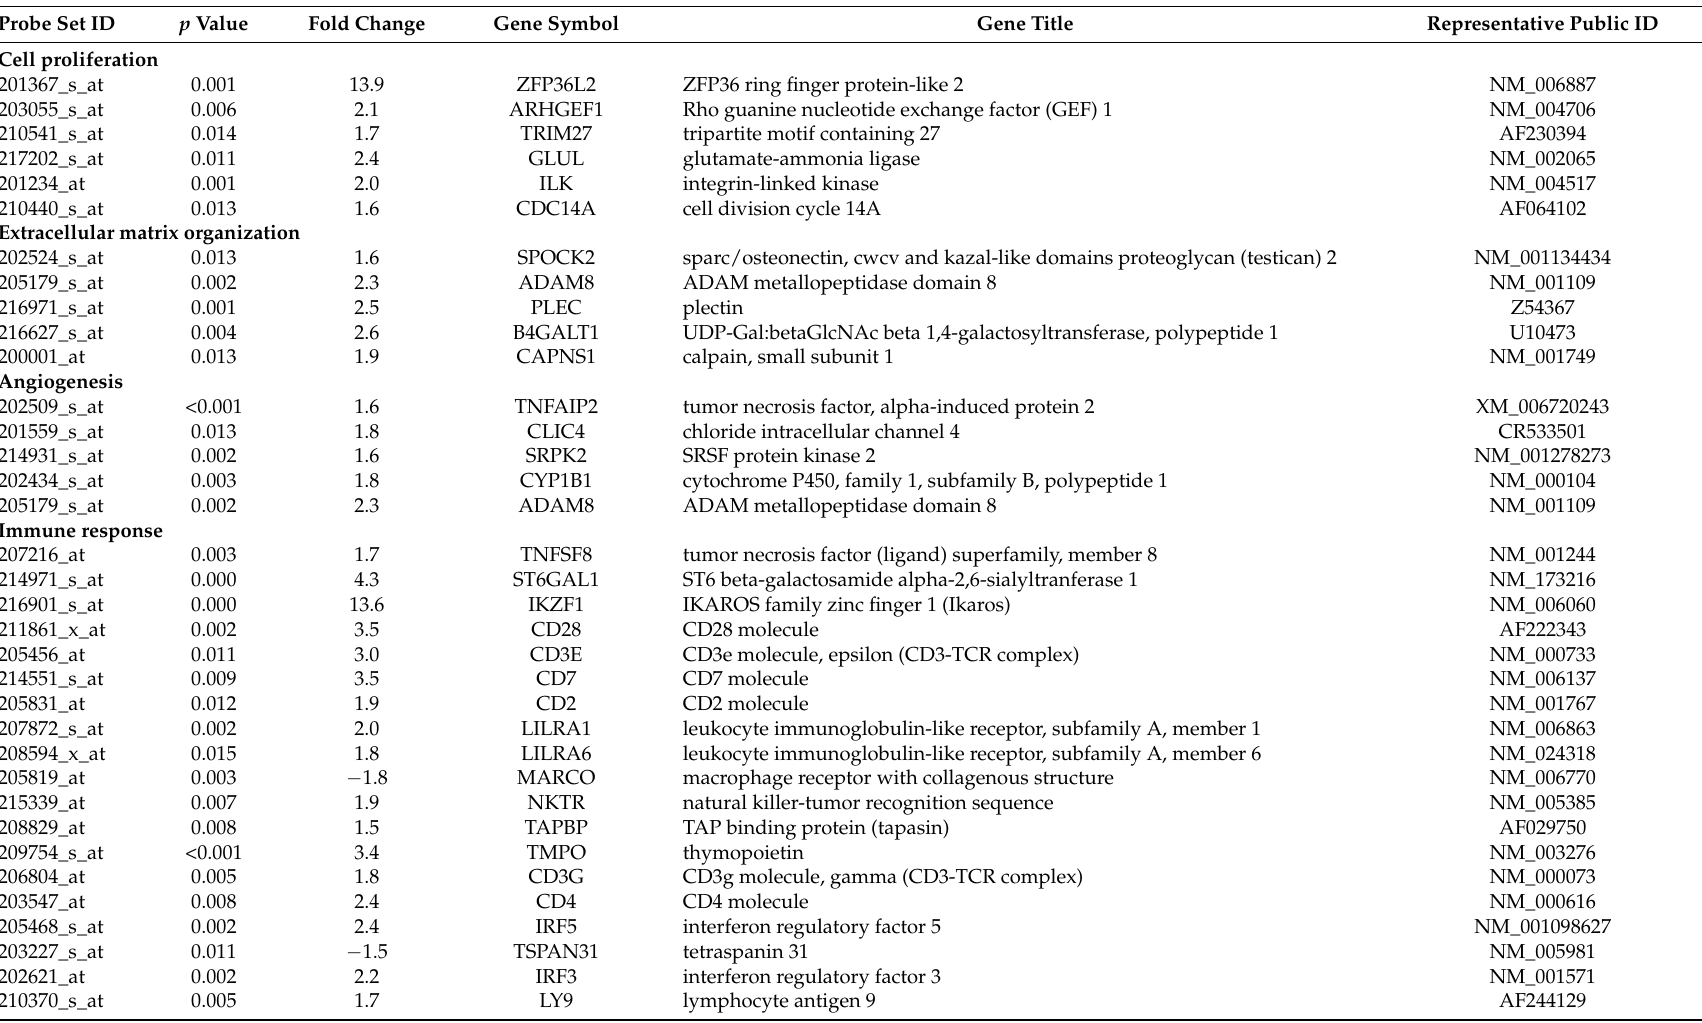
Table 1. Genes modulated in Ankylosing spondylitis (AS) patients before treatment versus healthy